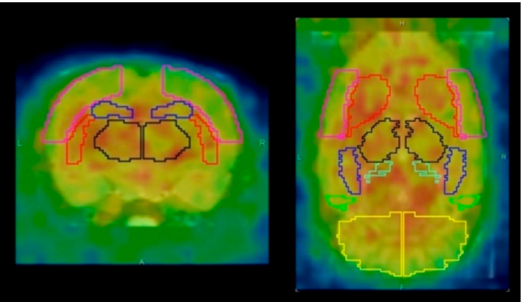
Figure 1. Axial and coronal positron emission tomography (PET) images with volume of interest (VOI) template (W. Schi ff er). Red line area indicated the striatum. Pink line area (the cerebral cortex), black line area (the thalamus), blue line area (the hippocampus), and yellow line area (the cerebellum) were also shown.